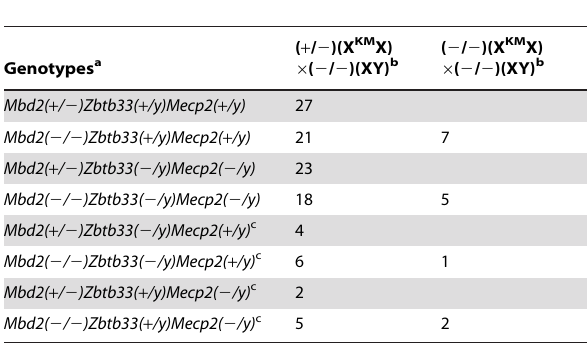
Table 1. Generation of triple KO mice.